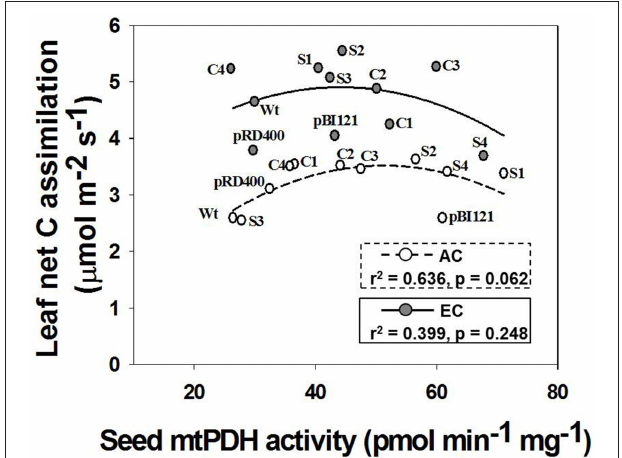
FIGURE 3 | Daytime net C assimilation in rosette leaves of Arabidopsis lines grown at either AC or EC. Quadratic regressions between rosette net C assimilation rate and seed mtPDH activity for all Arabidopsis lines is presented along with the r 2 value, significance levels, and lines of best fit. Photosynthetic rates of rosette leaves were determined at 49–53 DAS and plants were already flowering at this stage. CO 2 treatments: 380 ppm (AC, open circles/dashed line), 700 ppm (EC, closed circles/solid line). Values for photosynthesis represent the mean; n = 5 − 7 plants per line.